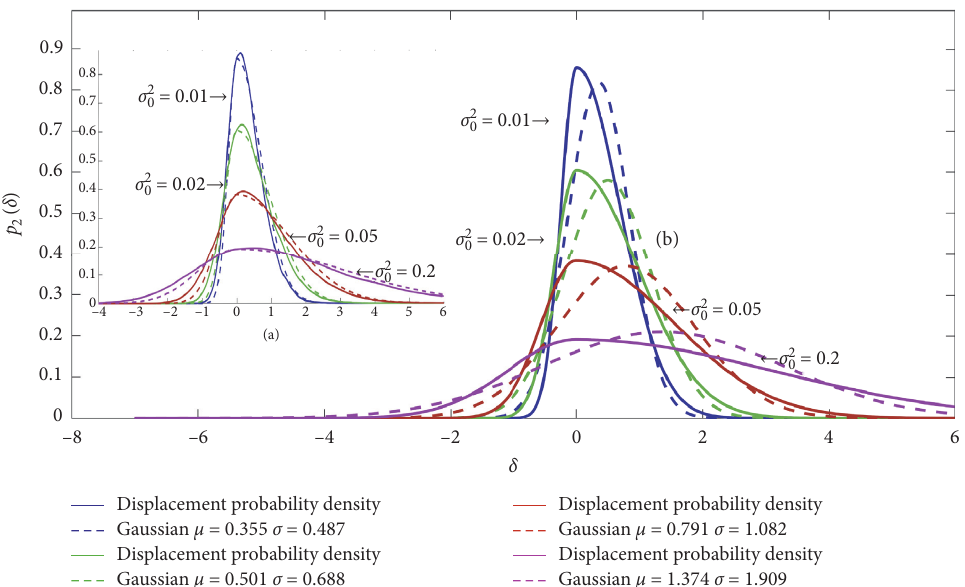
. (a) Comparison of the numerical and theoretical solution. (b) The result 0